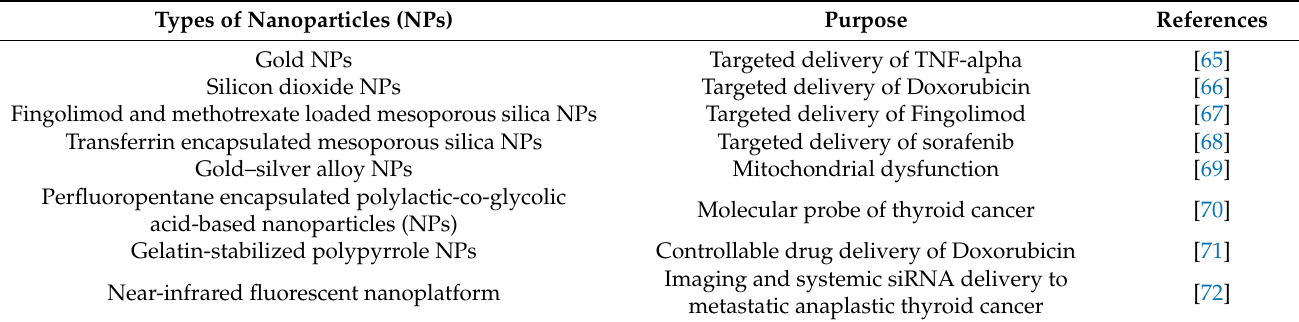
Table 2. List of nanoparticles used for efficient delivery of targeted inhibitors. Types of Nanoparticles